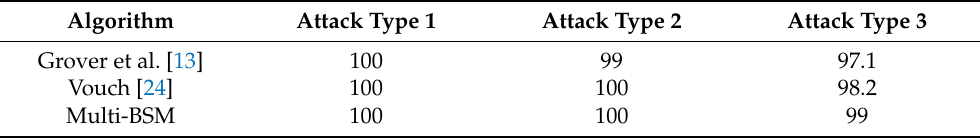
Table 5. Comparison of accuracy rate in medium vehicle density.